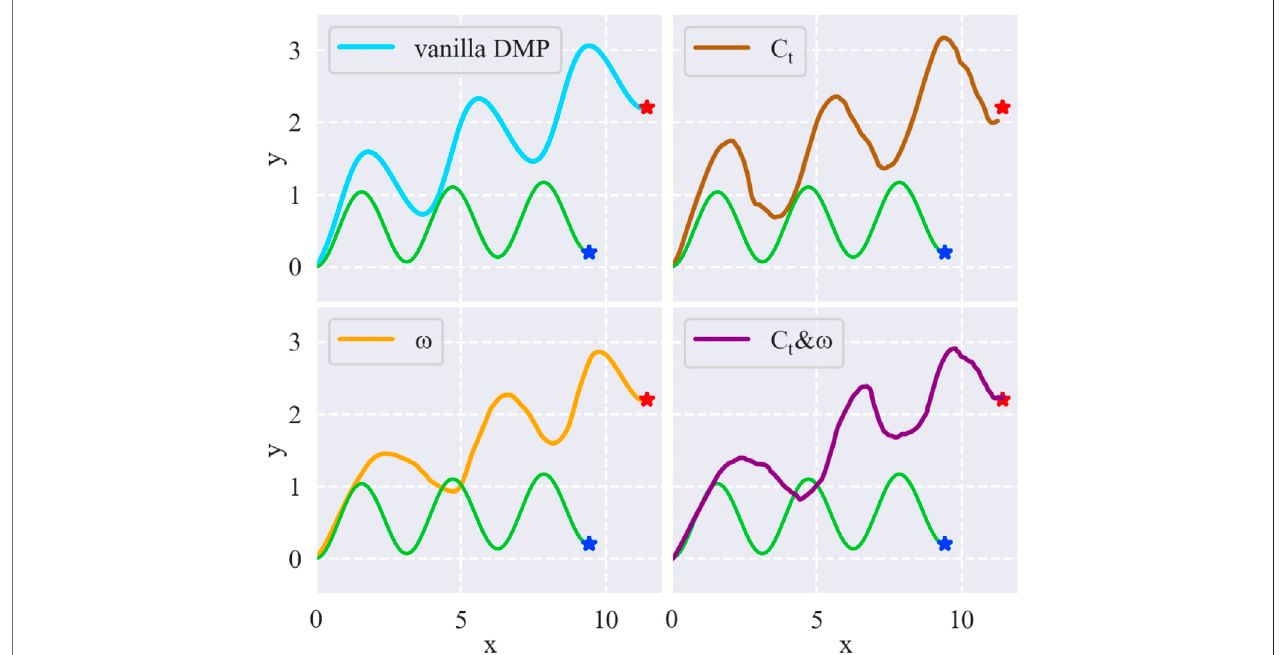
FIGURE4| Comparison ofdifferentresultingtrajectories bychangingdifferentcomponentsoftheDMPsformulation.Greenlineistheoriginalsinewavetrajectory. Blue star and red star are the original goal and the new goal, respectively.